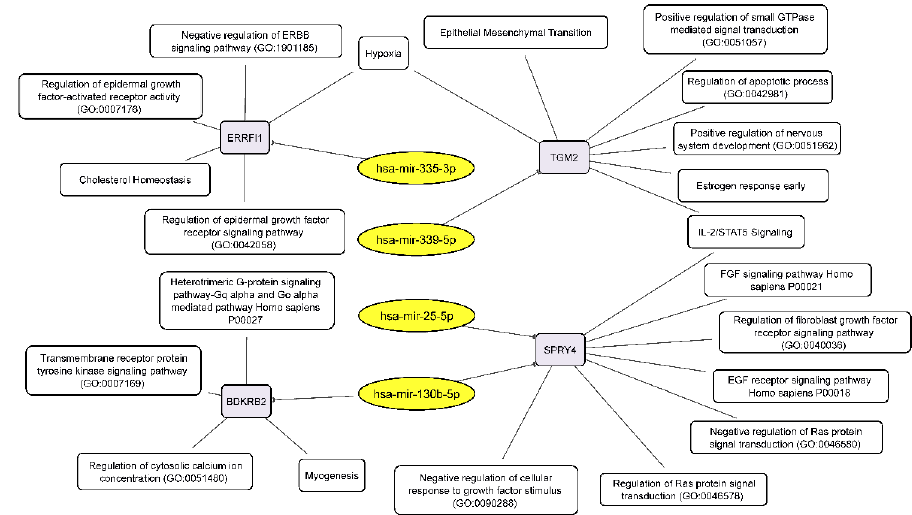
Figure 6. Integrated network analysis of downregulated miRNAs and their activated target mRNAs in GBM NS, as well as the participation of the latter in cellular processes. Yellow ovals represent miRNAs, gray round rectangles—mRNA-targets, white round rectangles—cellular processes and signaling pathways.